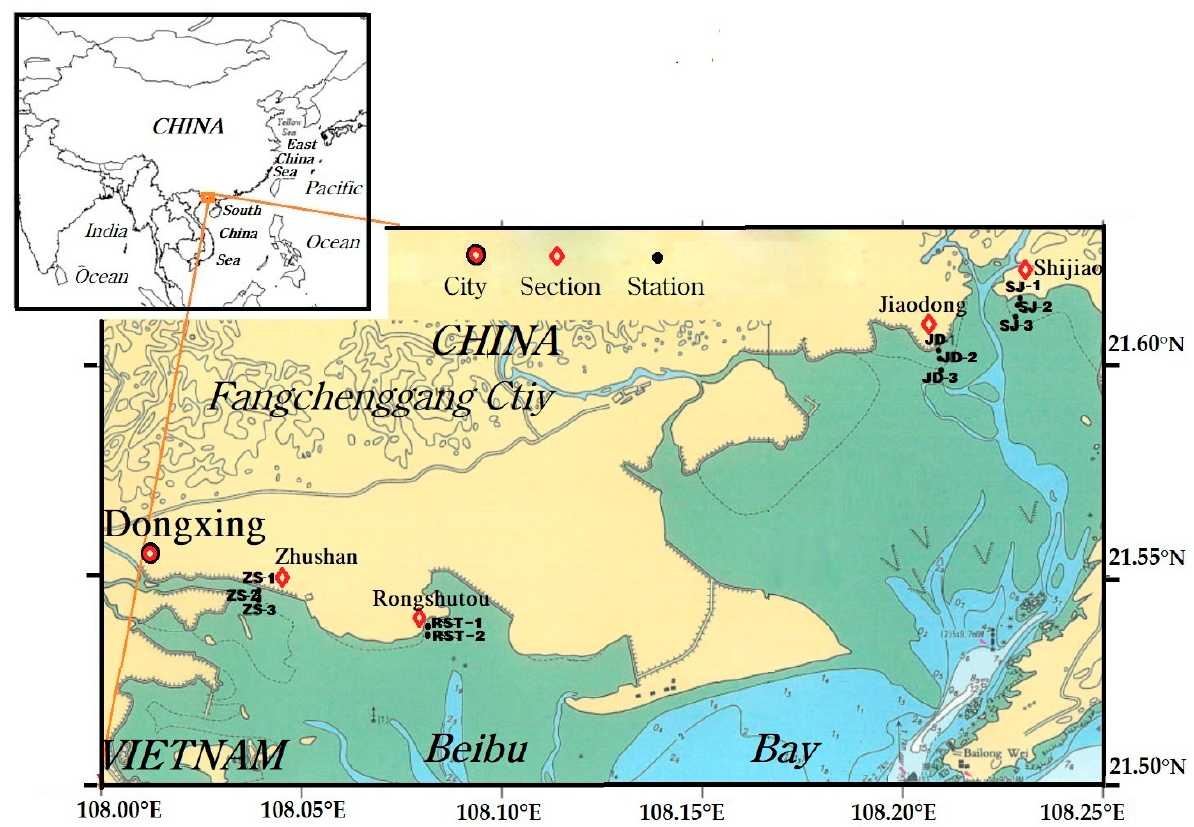
Figure 1. Transects and stations of the debris monitoring in Beilun Estuary mangrove forest region.